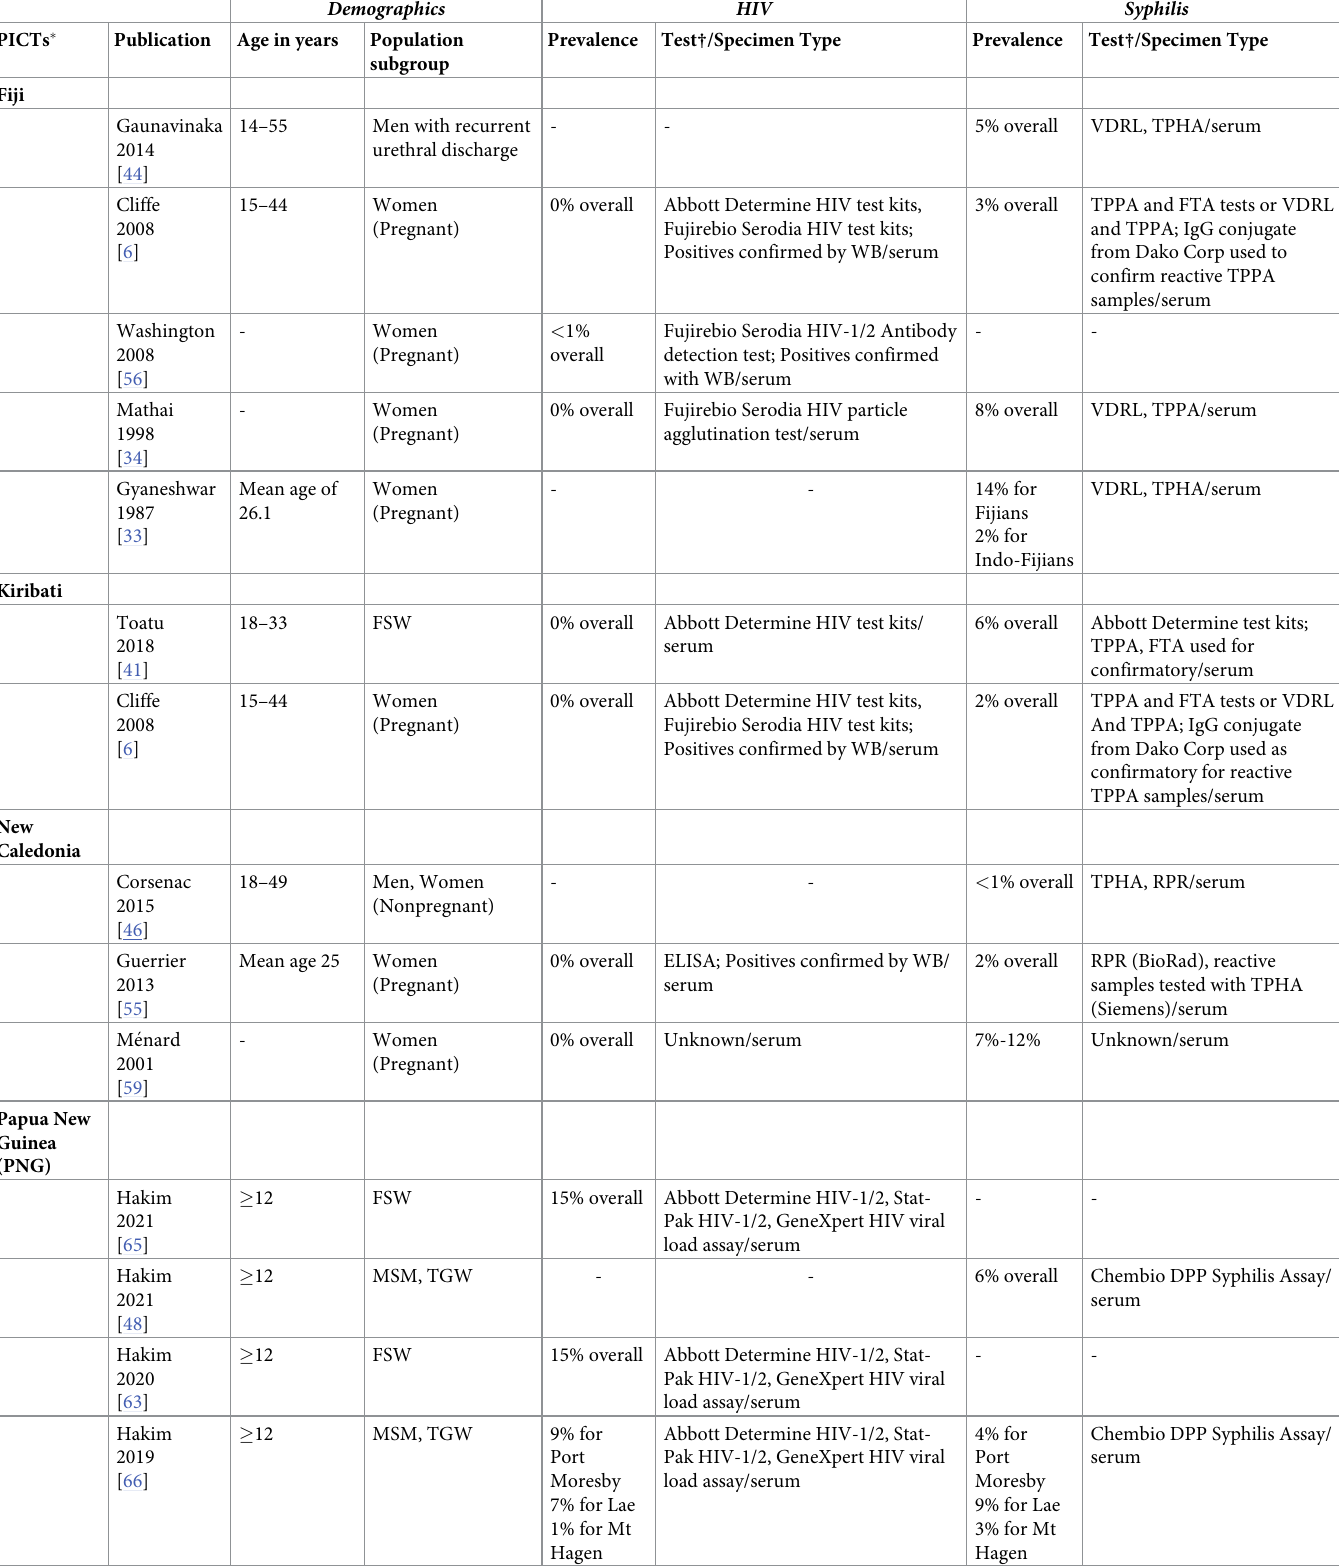
Table 2. Original research publications on HIV and syphilis in